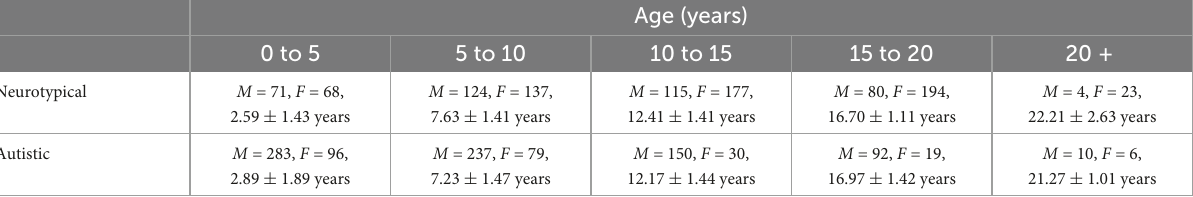
TABLE 1 Demographic breakdown of our two